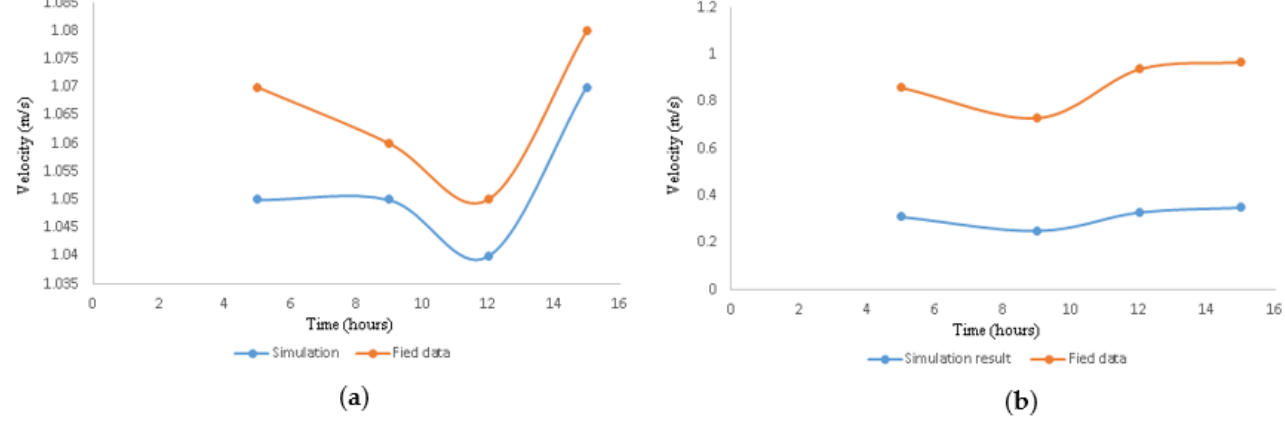
Figure 9. Verification of current velocity ( a ) Pantoloan port and ( b ) river mouth.